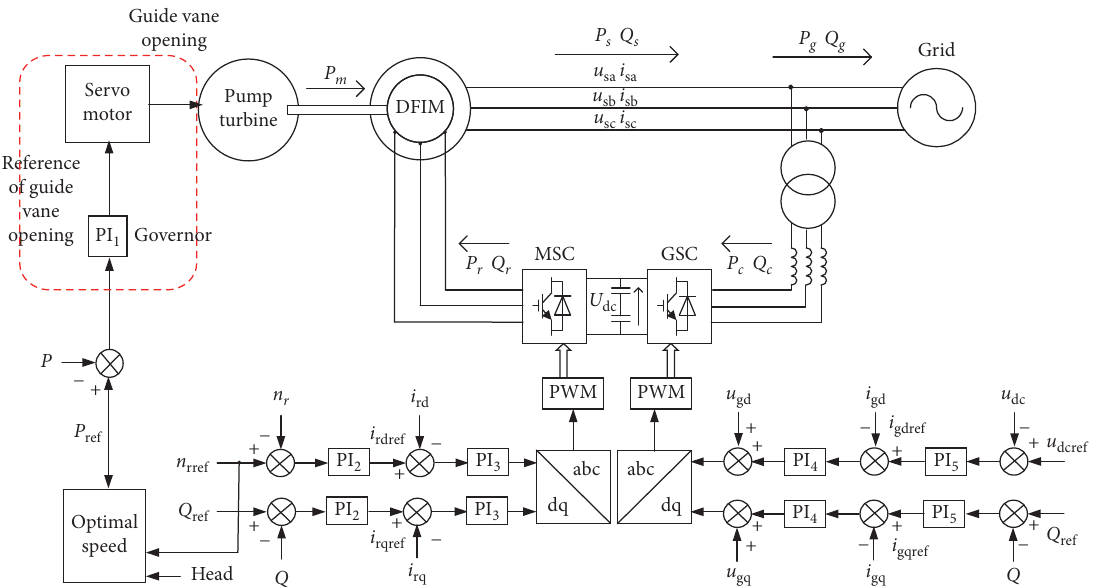
Figure 6: Control strategy diagram of the speed priority control strategy.